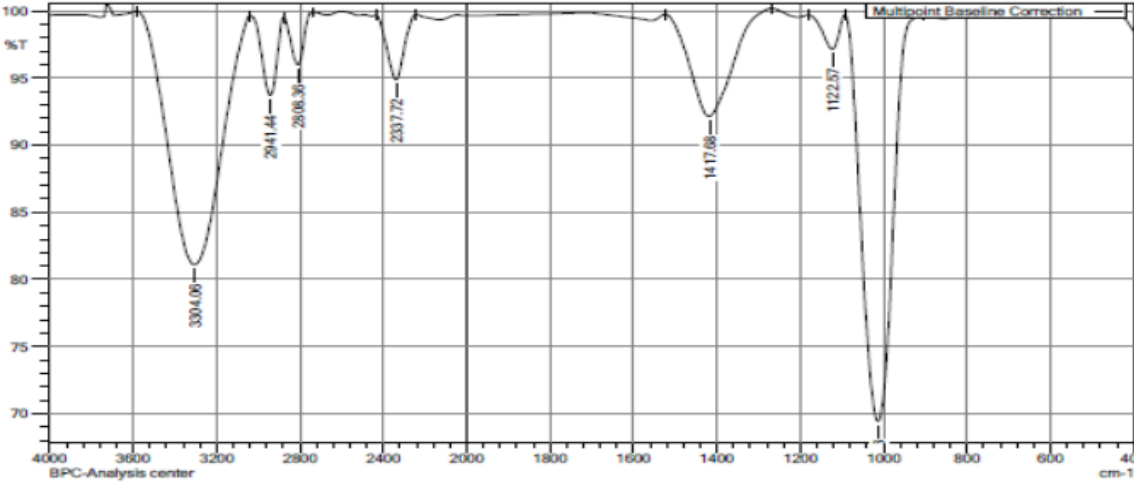
Figure 16. IR spectrum of isolated cpdC2. Table 6. interpretation of the IR bands for C2 were shown below